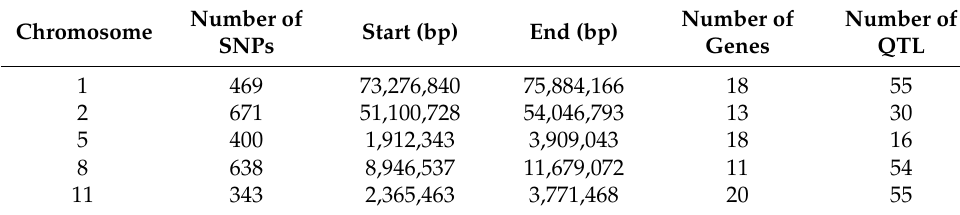
Table 3. Annotation results and ROH islands.